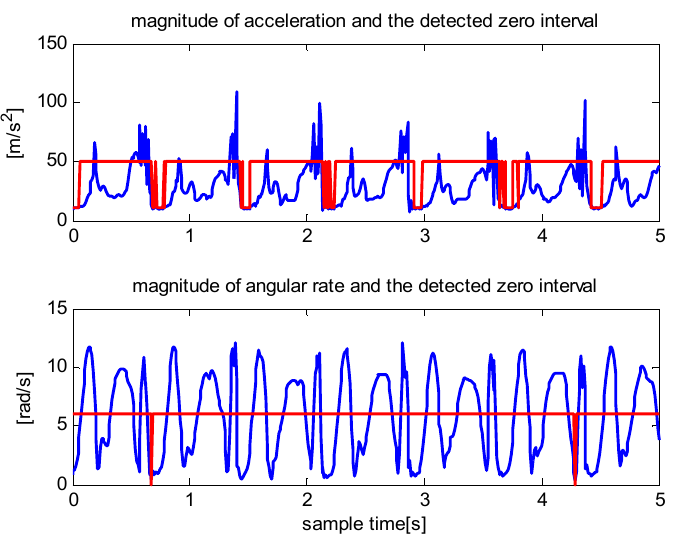
Figure 2. The detected zero velocity interval when a pedestrian is running. In these time intervals, there are no false detections for the accelerometer ( upper ). However, only two zero velocity intervals are detected for the gyroscope ( lower ).